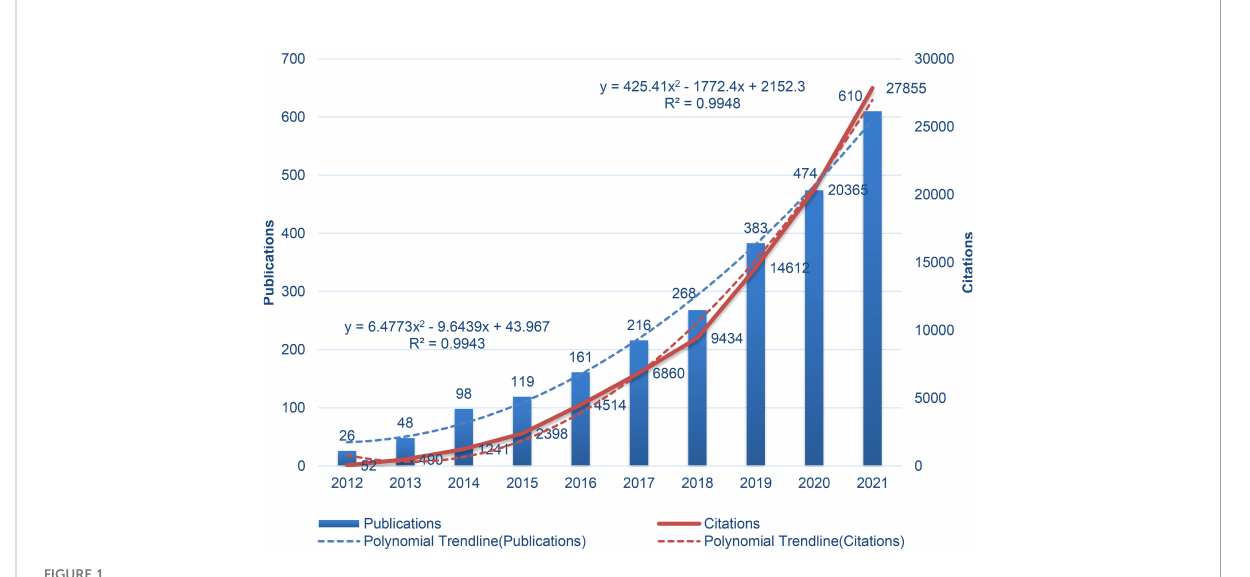
FIGURE 1 Annual trends in FMT research publications and